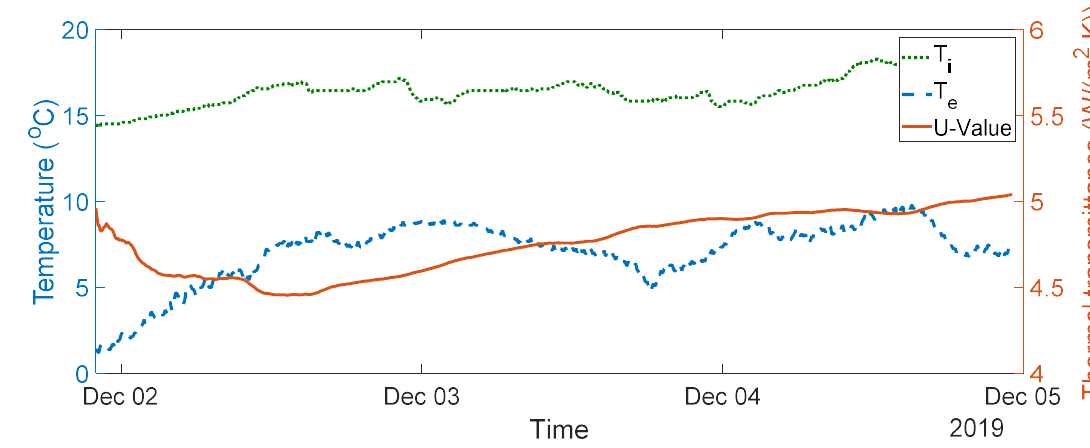
Figure 10. Thermal transmittance (U-value) measurement data between Day 5 and Day 7.